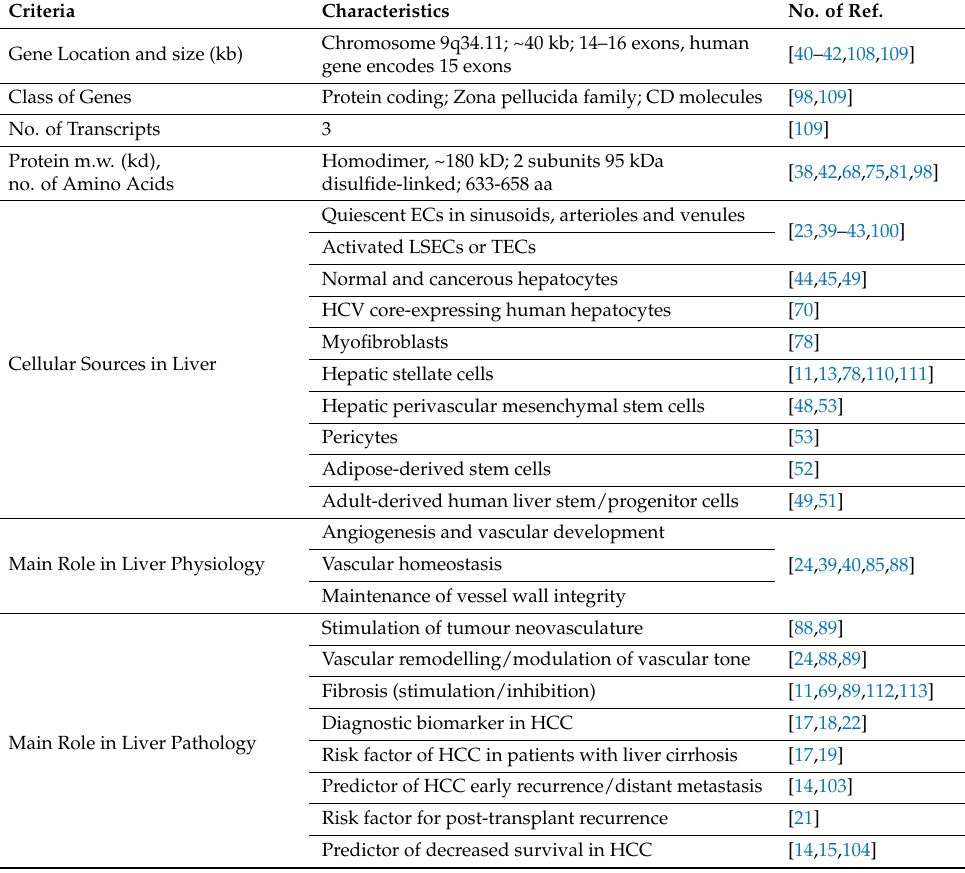
Table 1. The molecular structure of the endoglin (CD105), cellular sources in the liver, and the principal role in the liver physiology and